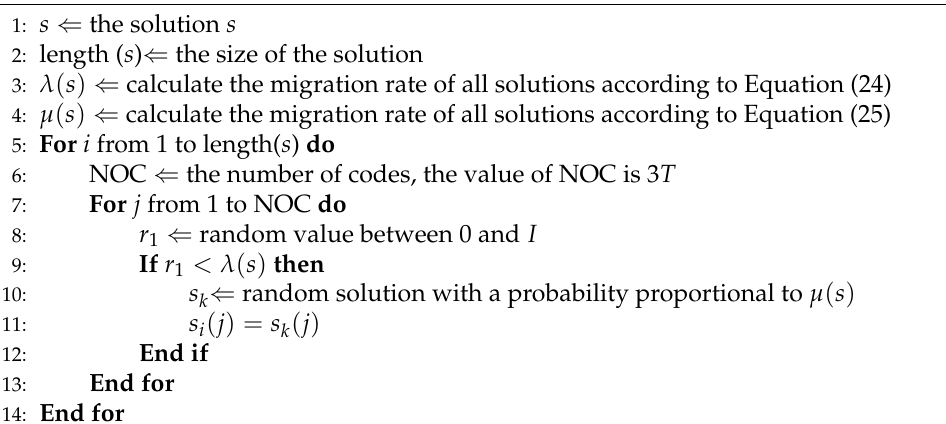
Algorithm 1 The pseudo-code of the migration